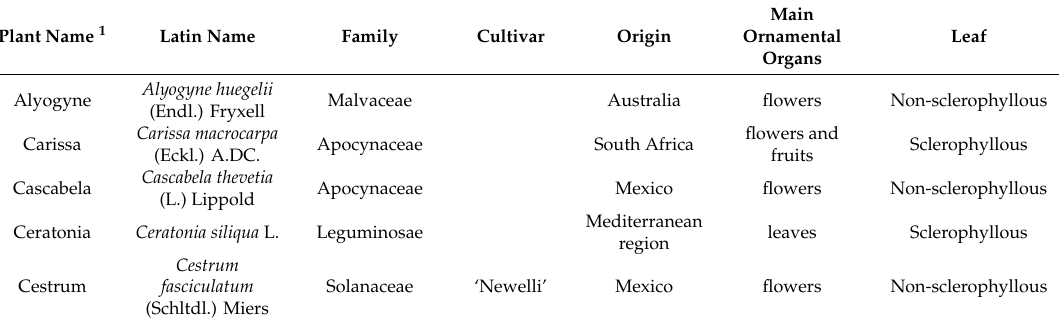
Table 1. Main botanical information for the twenty-four ornamental shrubs involved in this